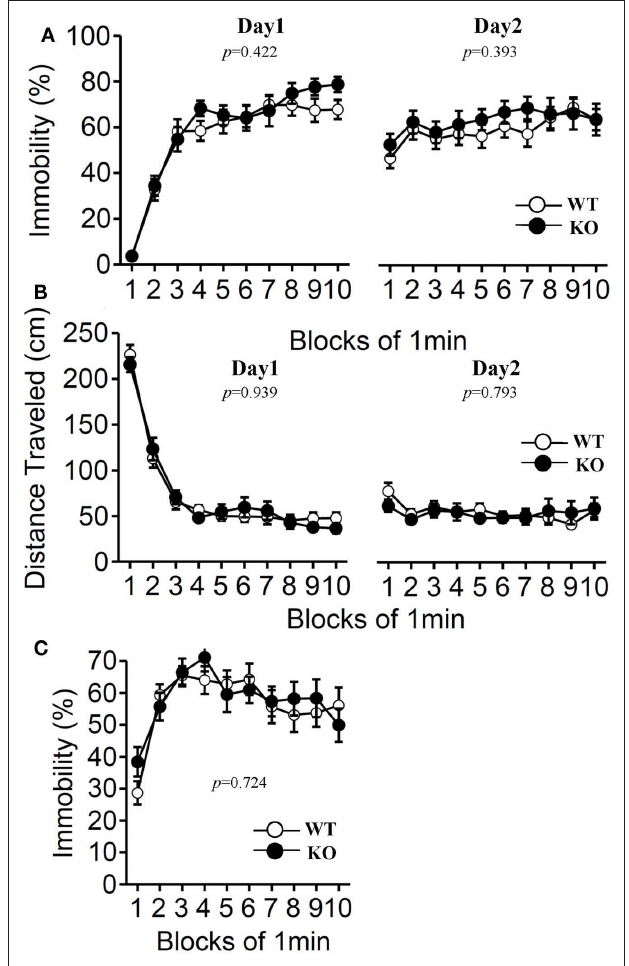
Figure 9 | Porsolt forced swim test and tail suspension test. The Porsolt forced swim test (A,B) . Immobility time (A) and total distance traveled (B) were recorded in each block for days 1 and 2 ( n = 20 each). Tail suspension test (C) . Data are presented as mean ± SEM. p -Values indicate significance of genotype effect in two-way repeated